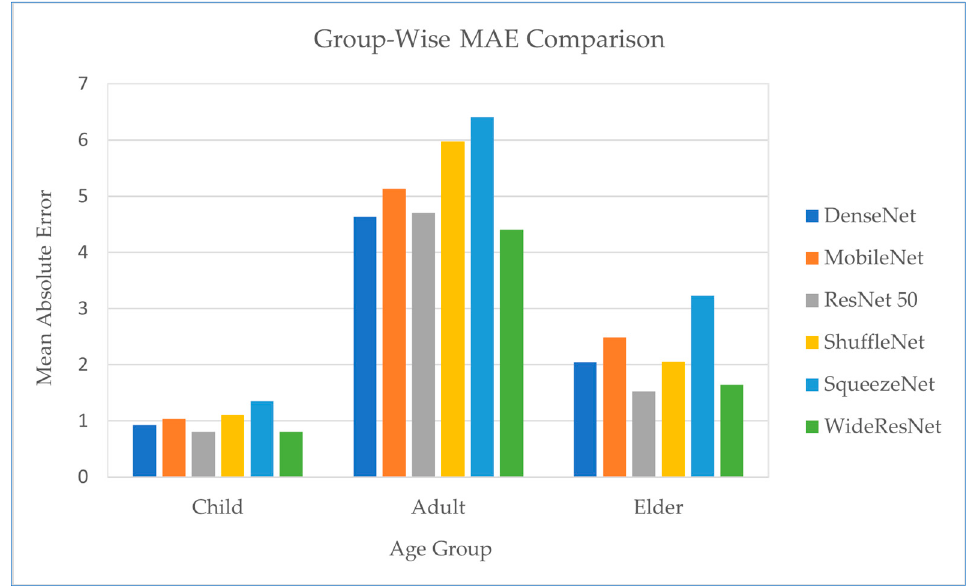
Figure 8. The performance of deployed models over age groups in terms of mean absolute error. Table 4. Sample images with corresponding mean absolute error evaluated by the best model.